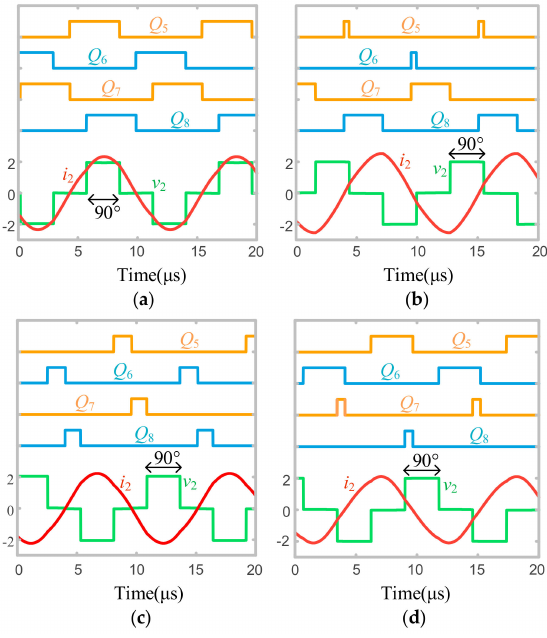
Figure 12. Simulated results of proposed dead-time elimination method. ( a ) Region 1; ( b ) Region 2;